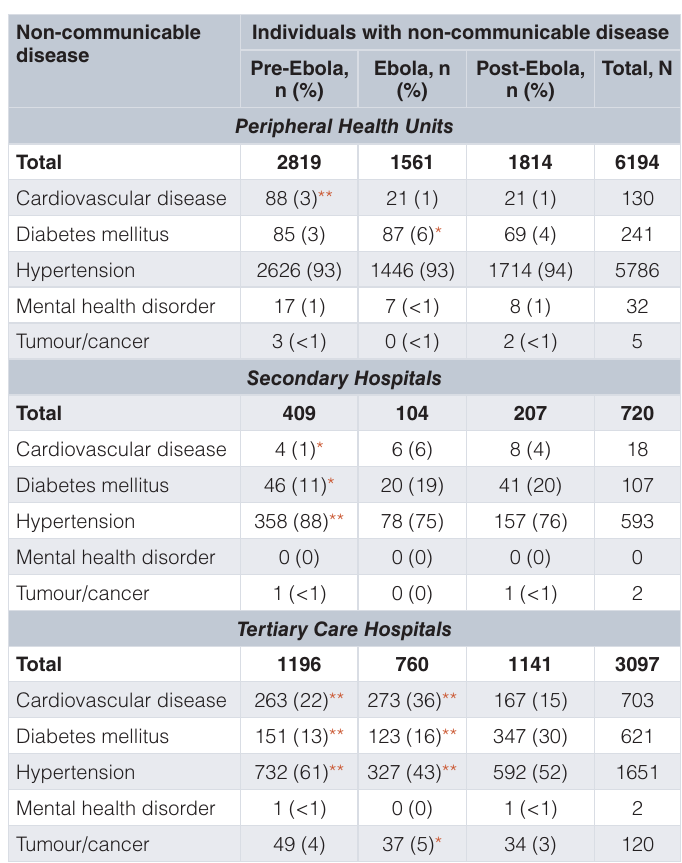
Table 2. People with non-communicable diseases by level of health facility in the Pre-Ebola, Ebola, and Post-Ebola periods, Western Area District, Sierra Leone: 2013–2015. Pre-Ebola: June to December 2013; Ebola: June to December 2014; Post-Ebola: June to December